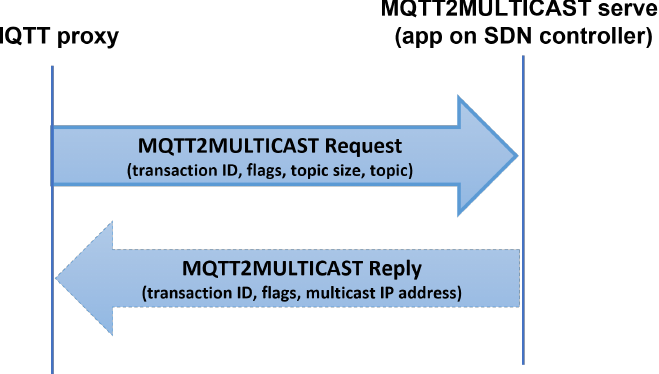
Figure 5. MQTT2MULTICAST message